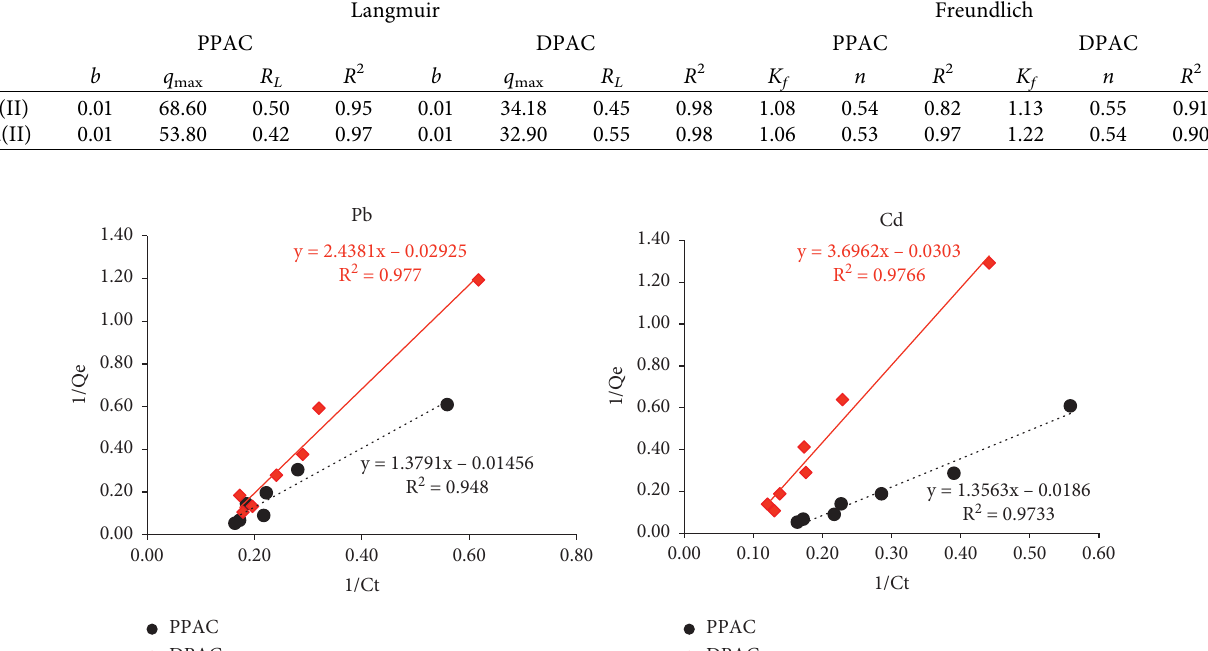
Table 4: Constants of Langmuir and Freundlich isotherms for Pb(II) and Cd(II) adsorption by DPAC and PPAC adsorbents. Langmuir